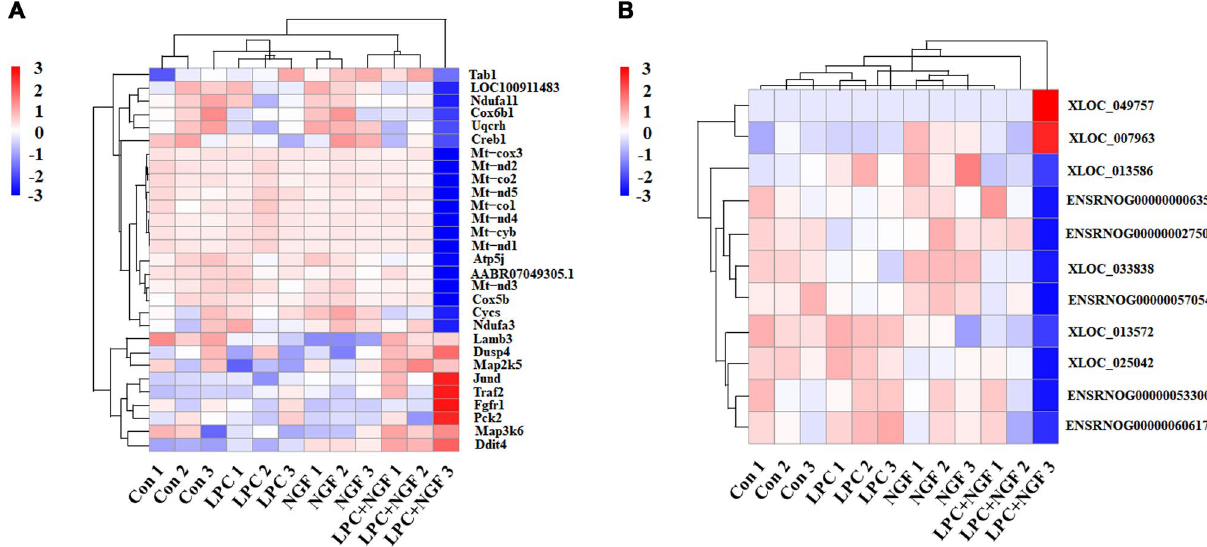
Figure 5. Co-expression network of lncRNAs and mRNAs in PC12. The squared nodes represent lncRNAs, whereas the circled nodes represent mRNAs; the node size is denoted based on degree (higher values are mapped to the bright color) and the edge is denoted based on the Pearson